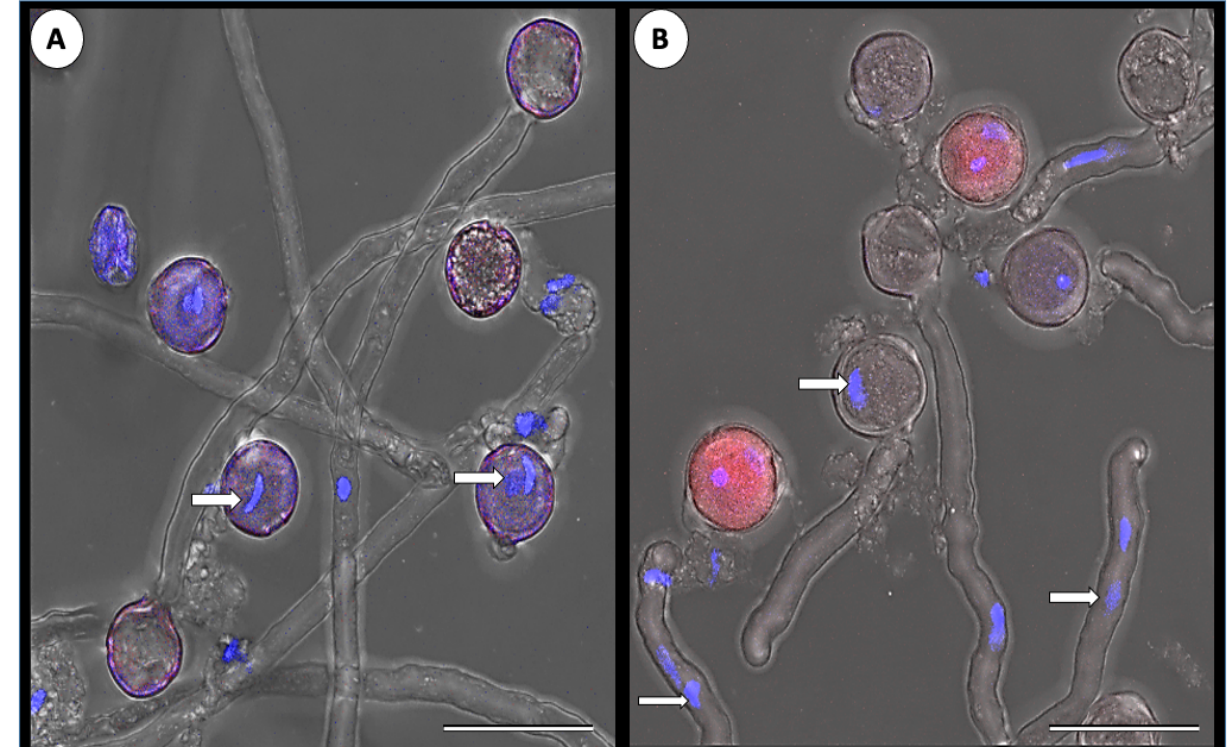
Figure 5. Representative confocal microphotographs of ToBRFV presence in germinating pollen grains of tomato. Pollen grains were allowed to germinate for 90 min, followed by DAPI staining and in situ hybridization with a specific ToBRFV DNA probe fluorescently labeled with Cy3. ( A ) Germination of pollen from control noninfected plant; nuclei stained in blue (DAPI) are visible in the pollen grain and tubes (arrows), Bar = 50 µm; ( B ) Germination of pollen from infected plant. Note that the infected grains do not germinate (stained in red). In germinating noninfected grains, nuclei are stained in blue (DAPI) and are visible in the grain and pollen tubes (arrows), Bar = 50 µm.